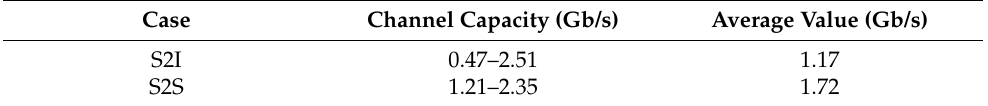
Table 4. Results of the channe